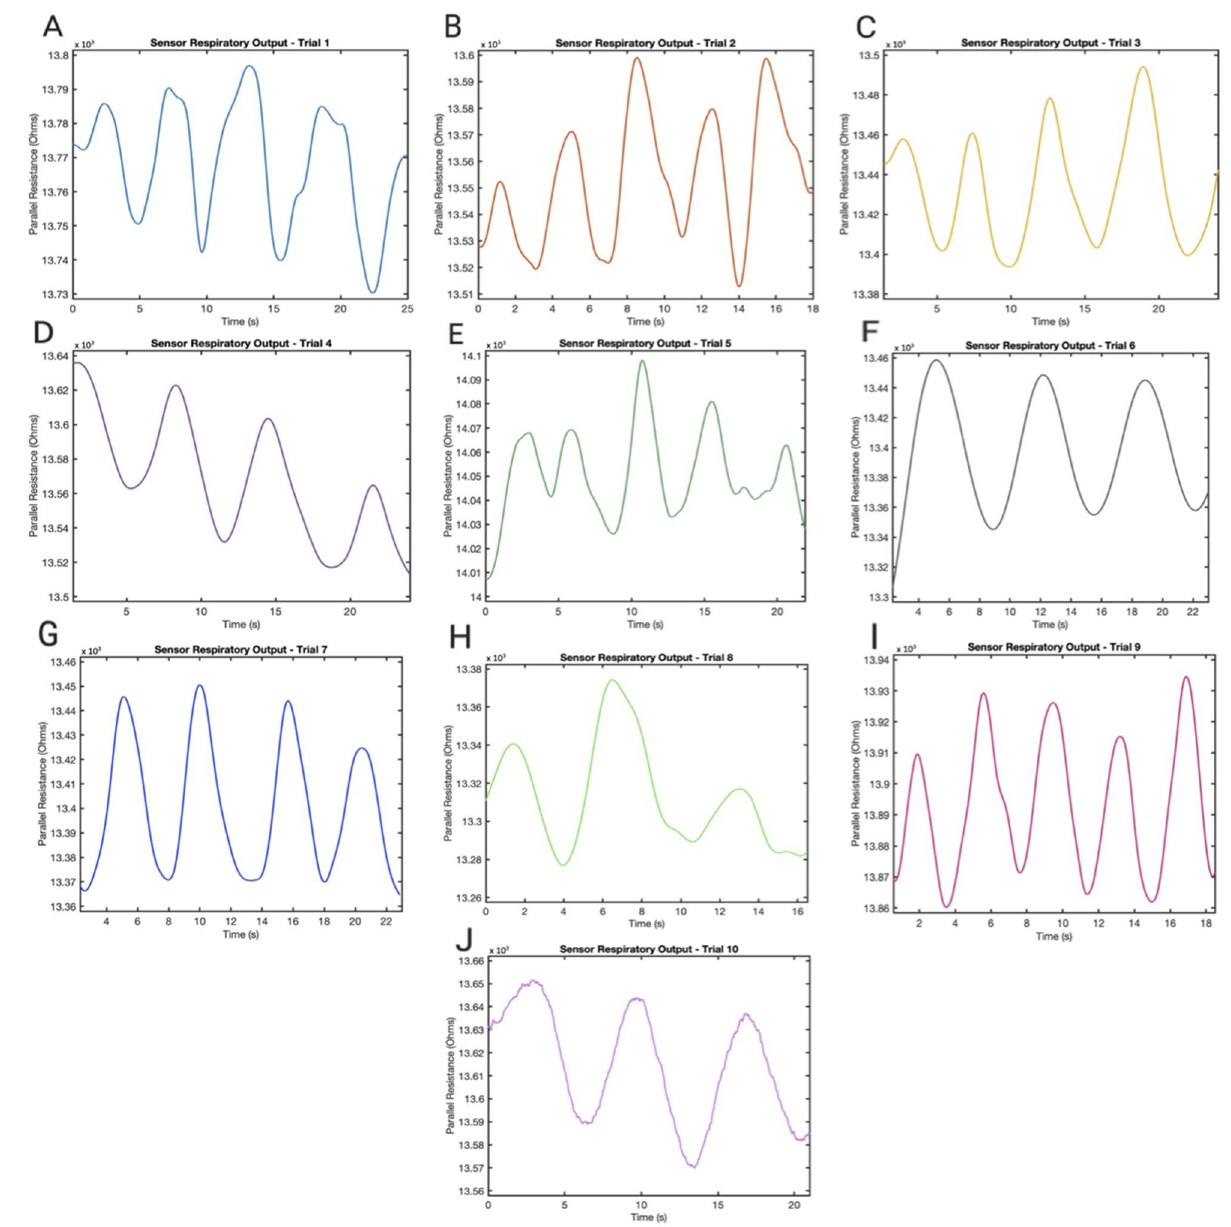
Figure 3. Sensor respiratory waveform output. ( A-J ) Each waveform shows the unique pulmonary waveform, as generated by the sensor, for each trial in this